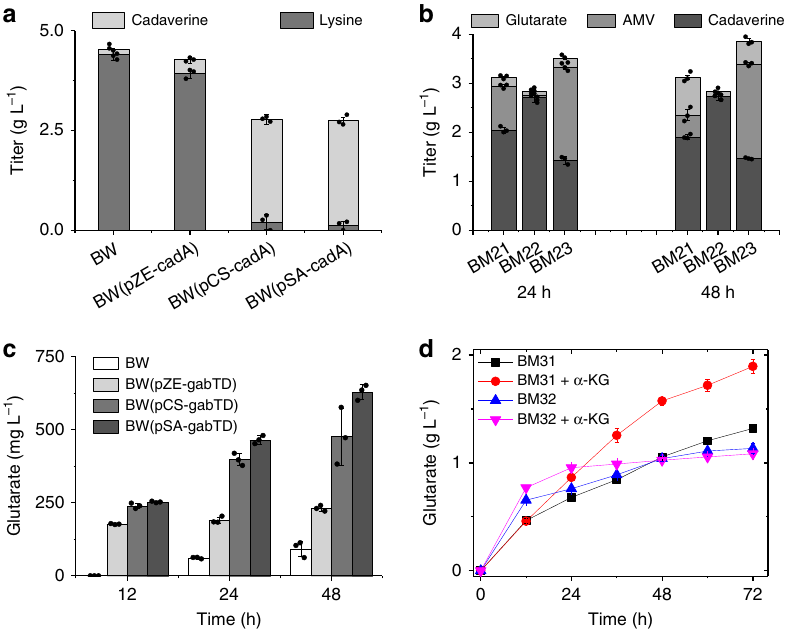
Fig. 2 Modular optimization of glutarate production from lysine. Optimization of a cadA module, b patAD module, and c gabTD module. d Glutarate production from lysine. α -KG, α -ketoglutarate. Data shown are mean ± SD ( n = 3 independent experiments). Source data are provided as a Source Data fi le